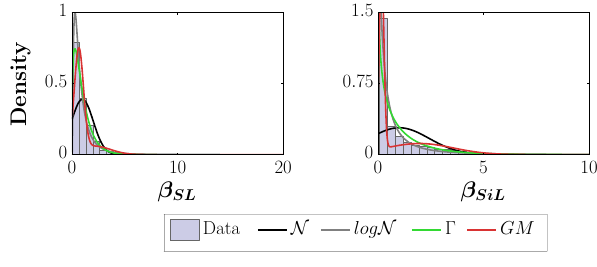
Fig. 13: Prior distribution of the scaling paramters β SL and β